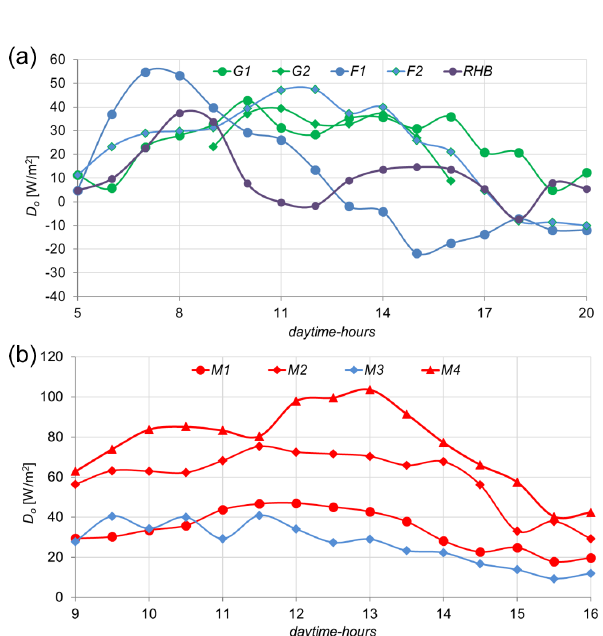
Figure 4. Differences D c = LE LY − LE EC_c : (a) as a function of daytime hours, humid; and (b) as a function of daytime hours, Ma- jadas; red: dry; blue: rainy season. gets smaller after correction, whereas SD ( LE LY ) remains the